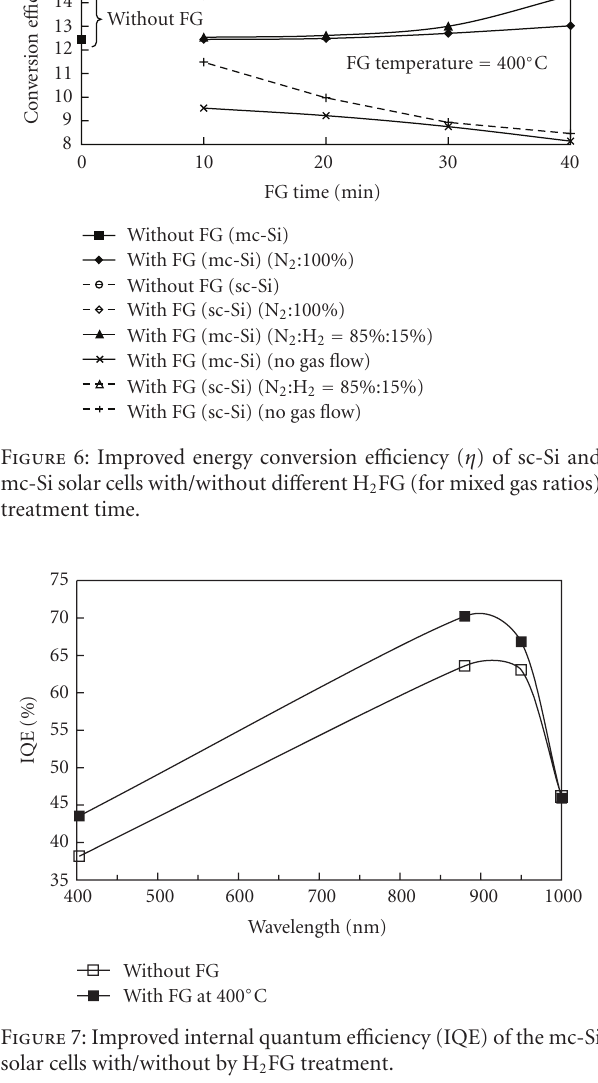
Figure 5: Improved Fill Factor of sc- and mc-Si Solar Cells at H 2 FG Treatment: 40 minutes (sc-Si: 69.92% → 73.93%, mc-Si: 59.43% → 72.63%).